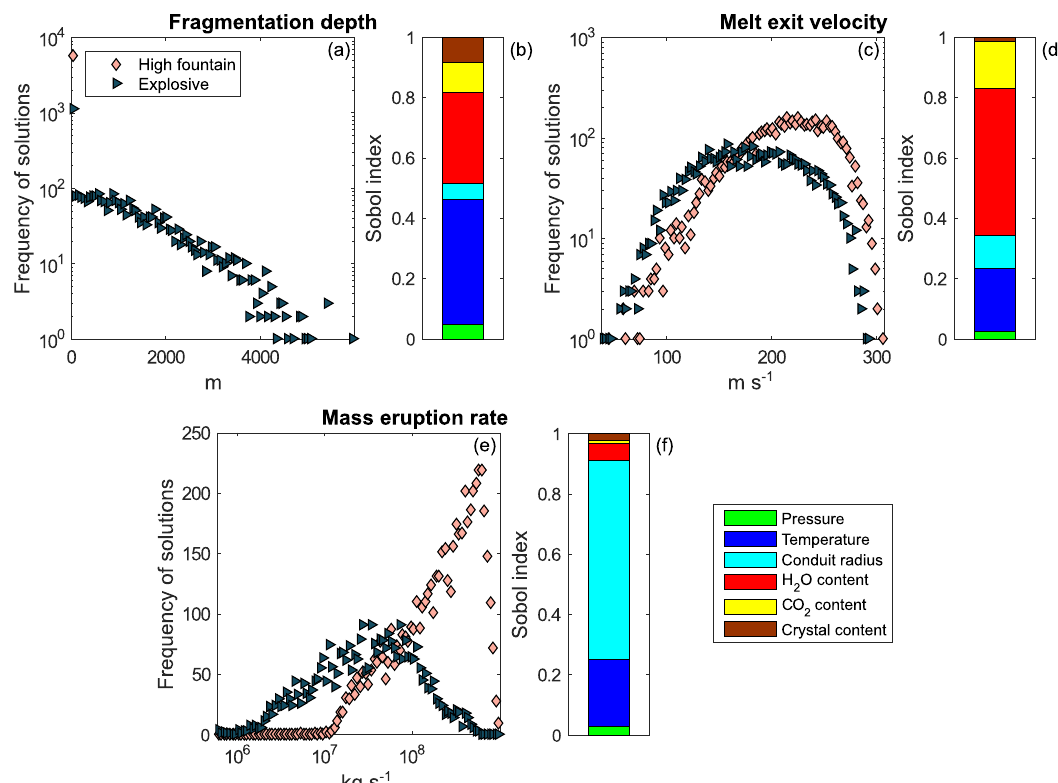
Fig. 4 Frequency of solutions as function of the investigated output parameters and the corresponding Sobol indexes resulting from the sensitivity analysis. We plot the number of solutions obtained from the sensitivity analysis as a function of selected output parameters and the corresponding Sobol indexes: ( a , b ) fragmentation depth; ( c , d ) melt exit velocity; ( e , f ) mass eruption rate. In contrast to what illustrated in Fig. 3, the sum of the frequencies here is variable, and is expressed as raw number (i.e. out of 10,000 runs). Explosive simulations are indicated with dark green triangles, whereas high fountains simulations are marked with pink